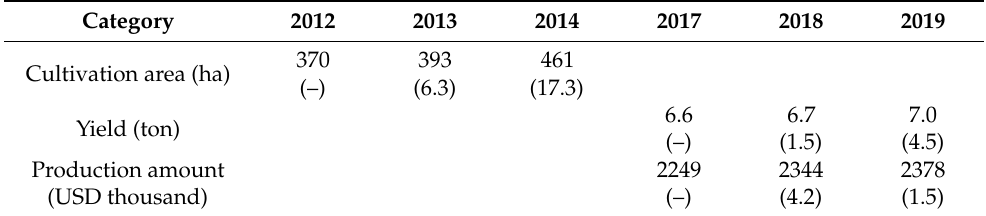
Table 3. Status of WSG cultivation area, yield, and production amount in the entire study